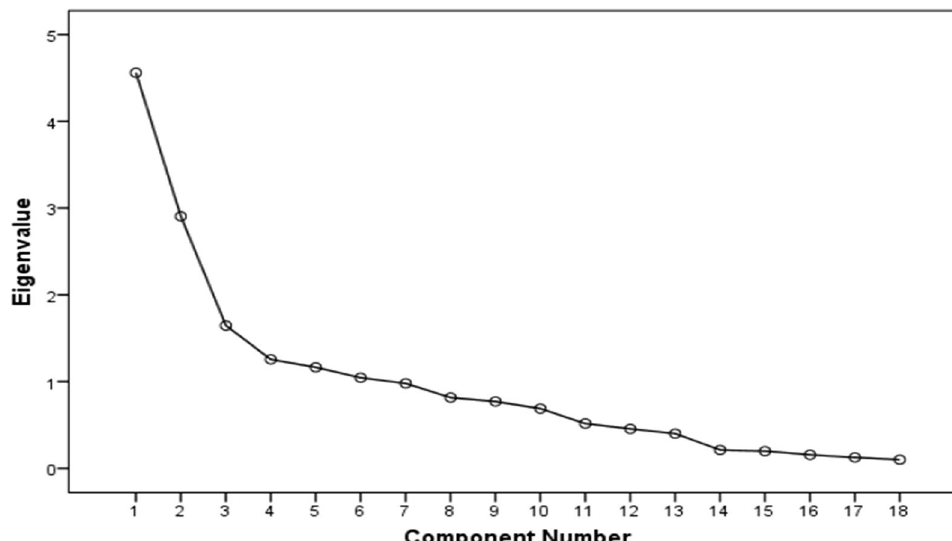
Fig. 4 Scree plot for PCA using conventional and truss morphometric measurements in H.